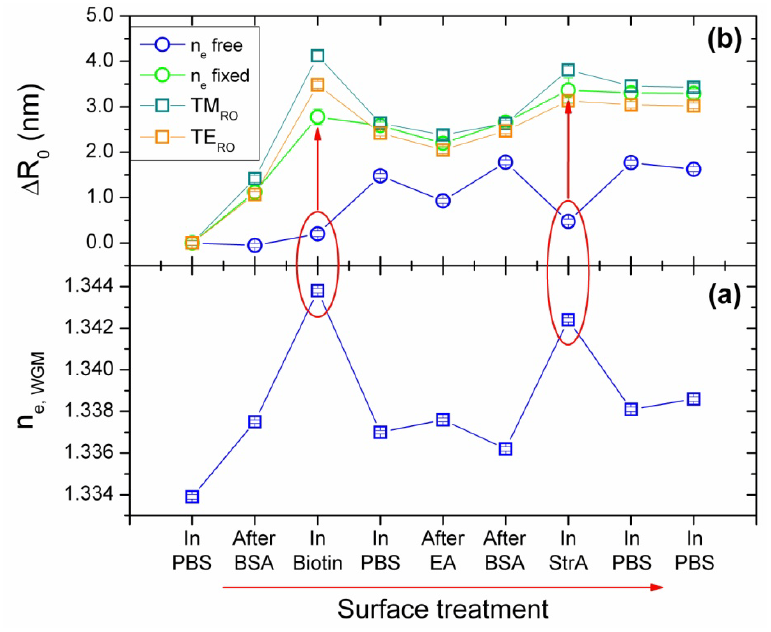
Figure 4. Results of the evaluation of WGM positions as determined after the indicated surface treatments; PBS—phosphate buffered saline, BSA—bovine serum Albumin, EA—ethanolamine hydrochloride, StrA—streptavidin, TM determined by ray optics model, n free—simultaneous fitting for n e Airy model, n fixed—fitting only for R by means of Airy model, keeping n e values obtained by